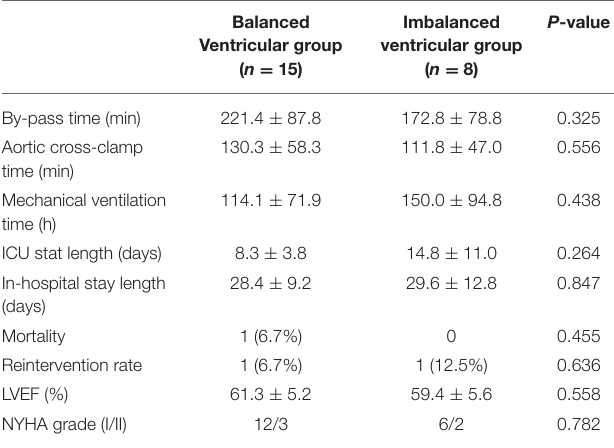
TABLE 5 | Postoperative outcomes stratified by different groups. Balanced Ventricular